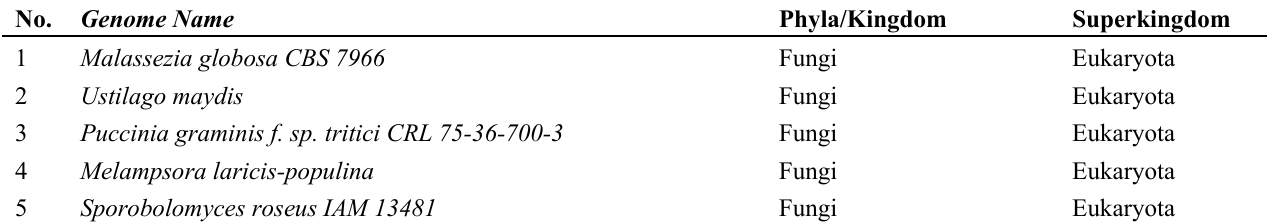
Table S5. List of organisms analyzed with their taxonomic